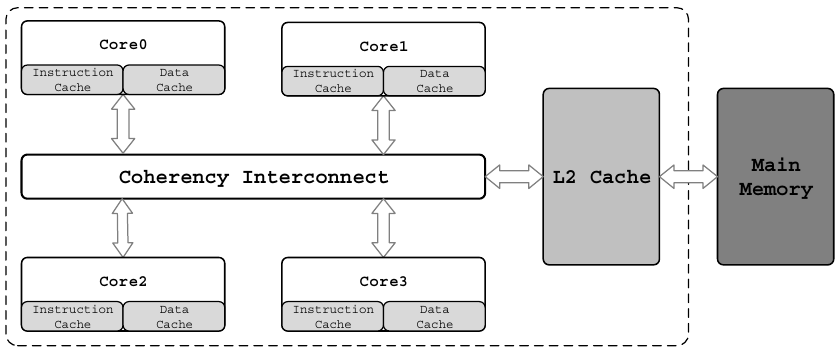
Figure 1. Typical multicore architecture with L1 and L2 caches.